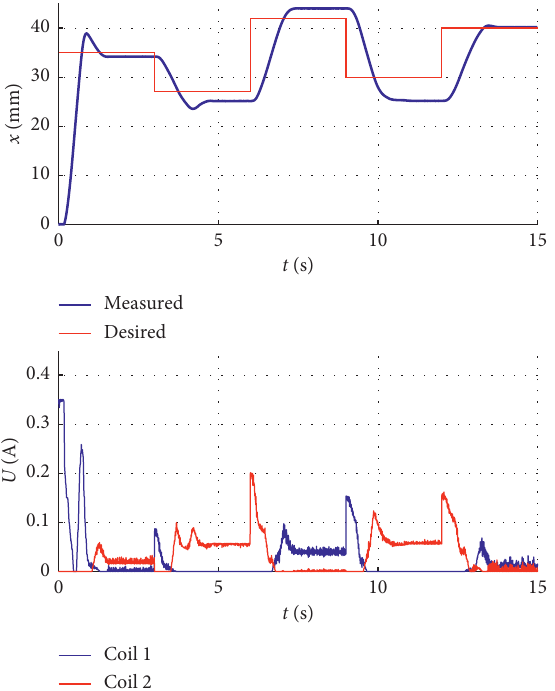
Figure 8: Example of the control performance for a controller based on the SNGP 10